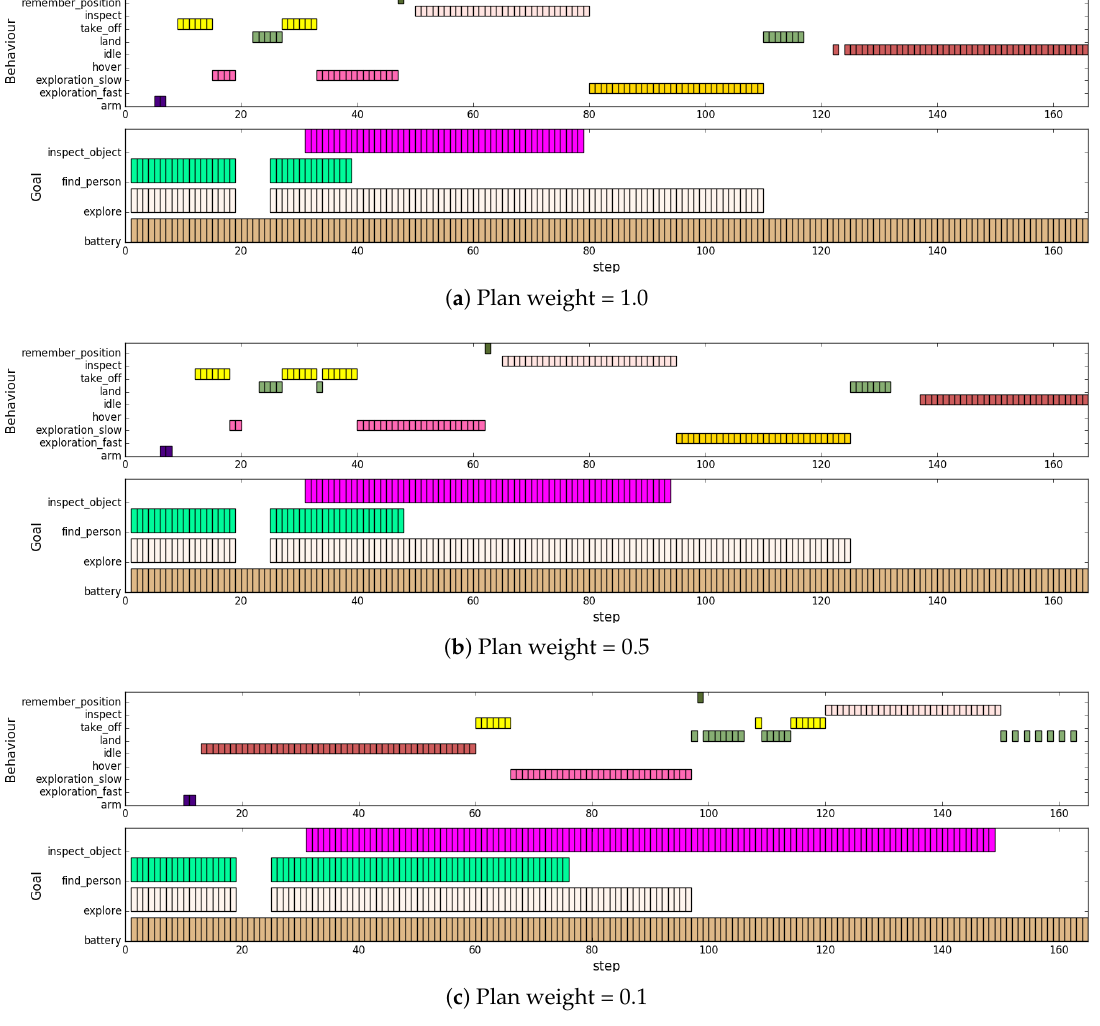
). Comparison between different s